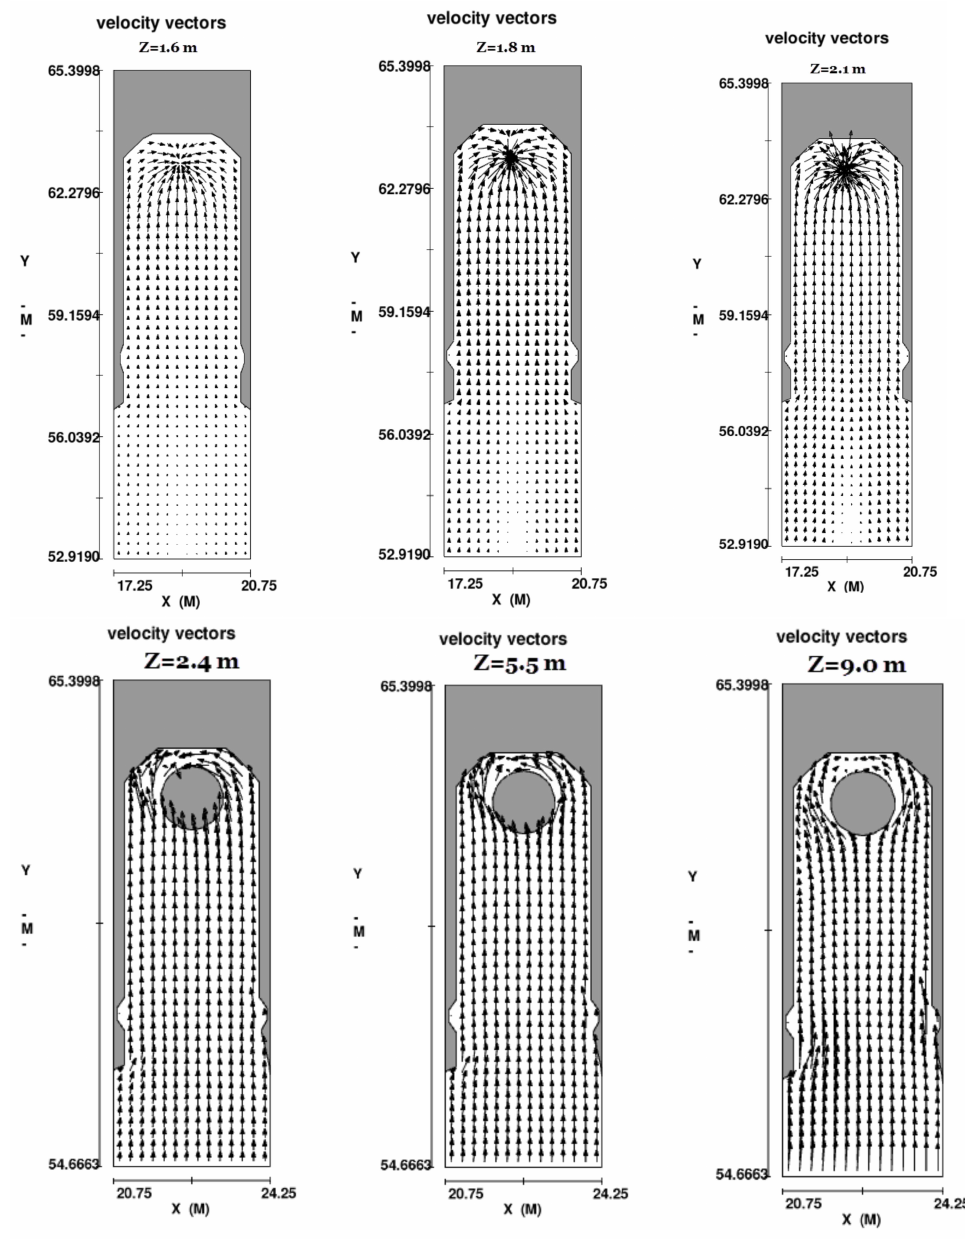
Figure 18. Vector field of velocity near a pump at different elevations—3D